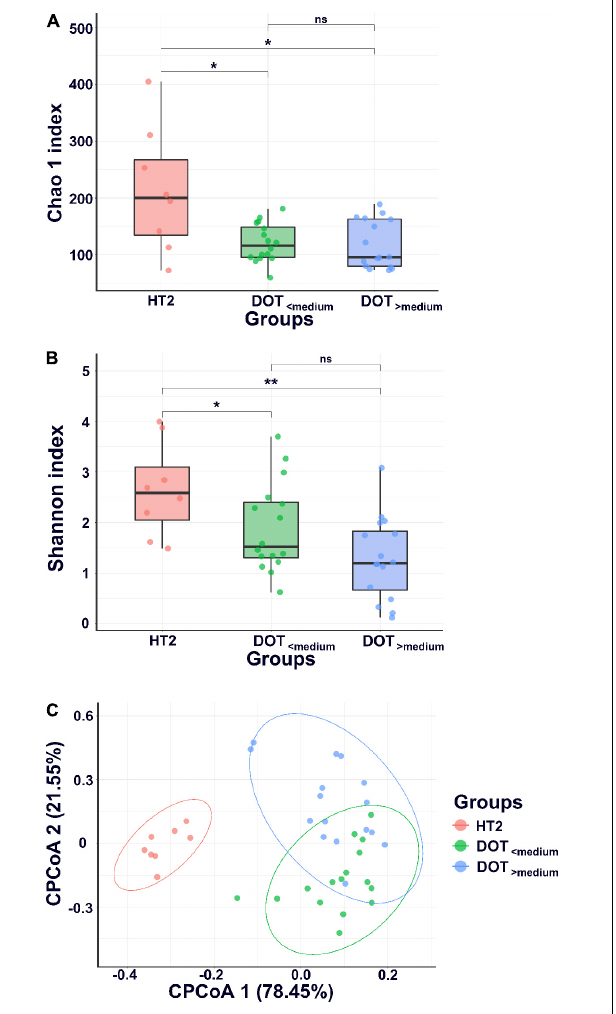
FIGURE 4 | α -diversity and β -diversity of gut microbiota. α -diversity indices, including Chao1 (A) and Shannon index (B) , and (C) β -diversity (CPCoA, covariate adjusted principal coordinates analysis, CPCoA) of gut microbiota of healthy term infants at 4 weeks of age (HT2) and preterm infants with DOT lower than median (DOT < median ) and DOT higher than median (DOT > median ). * p < 0.05; ** p < 0.01; ns,